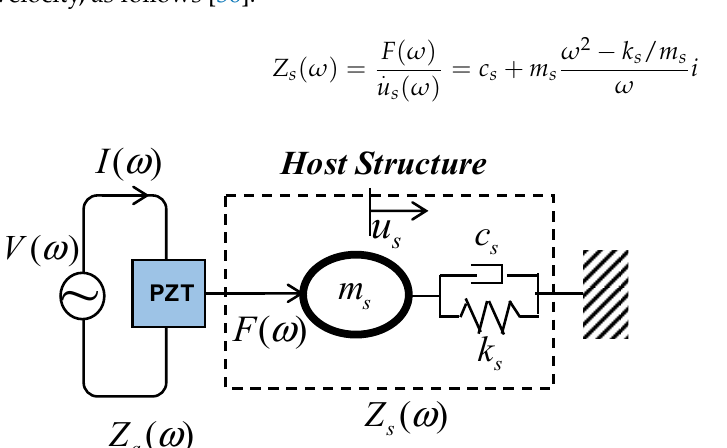
Figure 1. The one-dimensional model of PZT–host structure interaction ( u s is the displacement, I ( ω ) is the output current, V ( ω ) is the applied voltage).